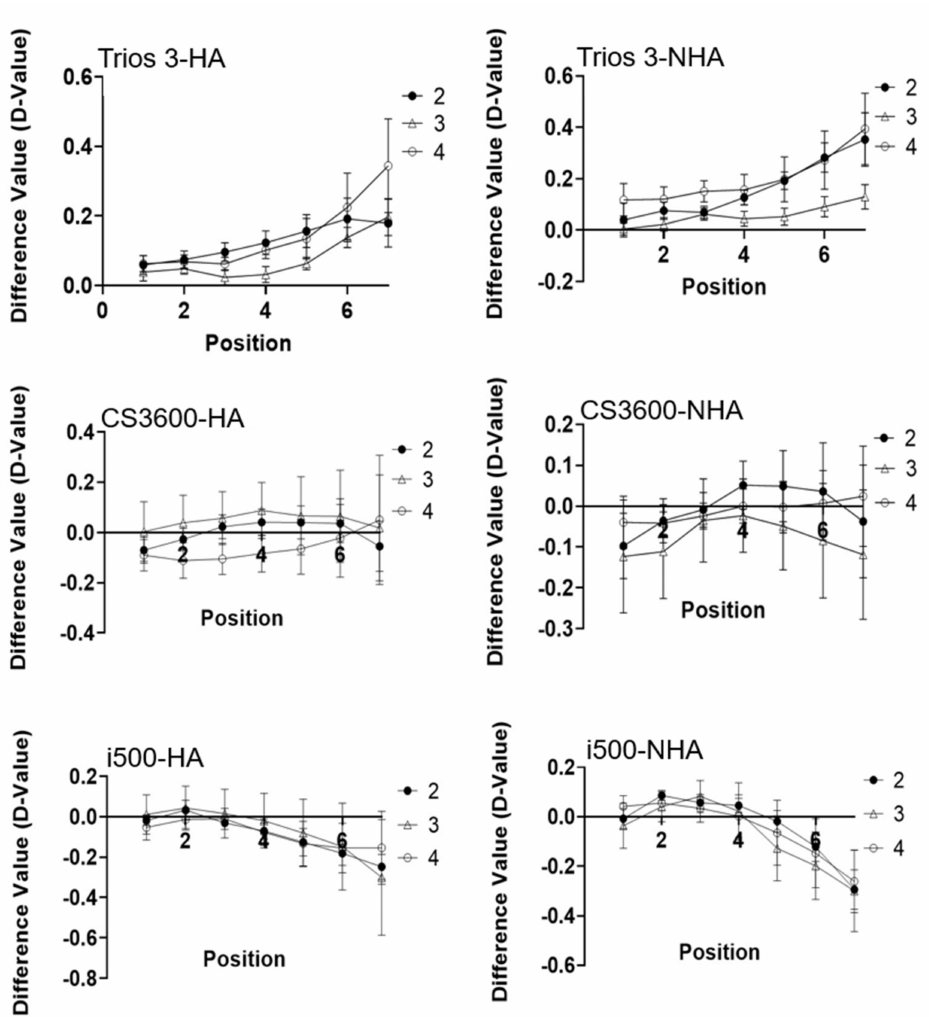
Figure 6. The difference values (D-Values) between the measurement scan distance (MSD) (acquired by IOSs) and the reference scan distance (RSD) (acquired by T500 scanner) for each tooth position. The three lines in each graph are for two, three, and four missing teeth. The numbers on the x-axes represent the position of the hemisphere. For the Trios 3 IOS, the D-value in all groups increased significantly as the tooth site moved posteriorly ( p < 0.05). For the i500 IOS, the D-Value in all groups decreased significantly as the tooth site moved posteriorly ( p < 0.05). Data are mean and standard deviation